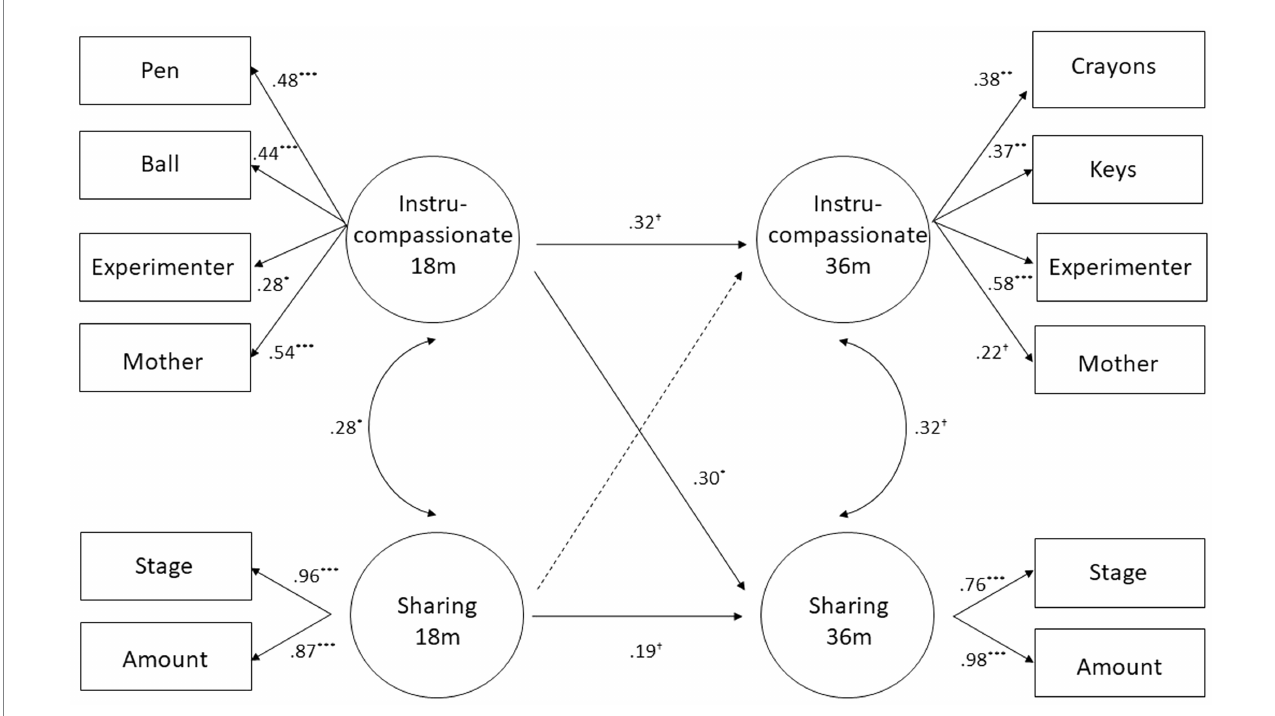
FIGURE 1 SEM model examining concurrent and longitudinal associations between latent variables of the two factors prosociality subtypes at 18 and 36 months. Significant paths and covariances appear in solid arrows, with standardized coefficients, and non-significant ones are in dotted arrows. † p < 0.10; * p < 0.05; ** p < 0.01; *** p < 0.001 (all